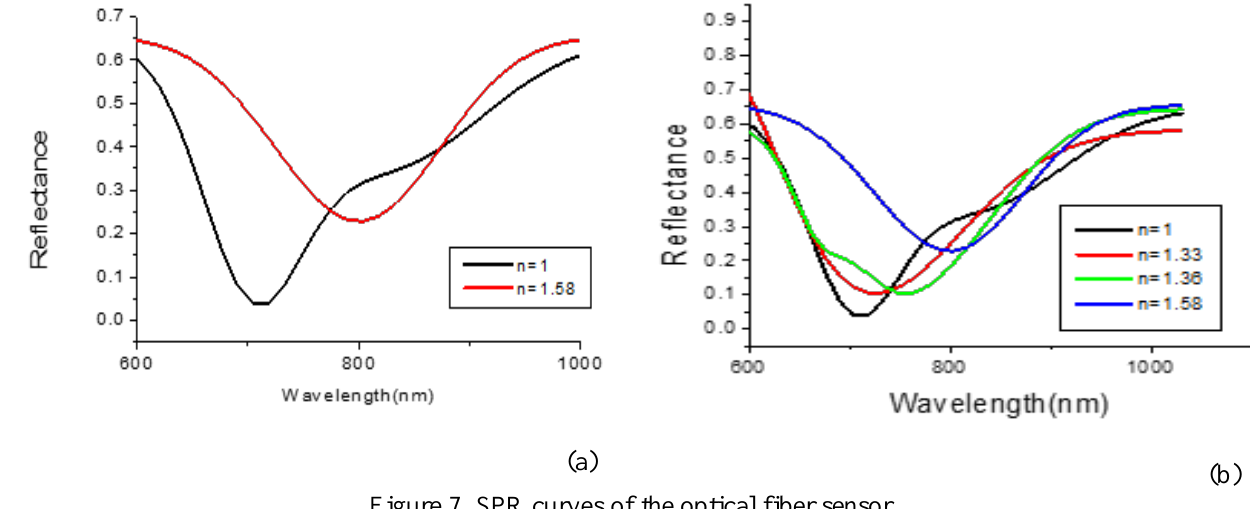
Figure 7. SPR curves of the optical fiber sensor